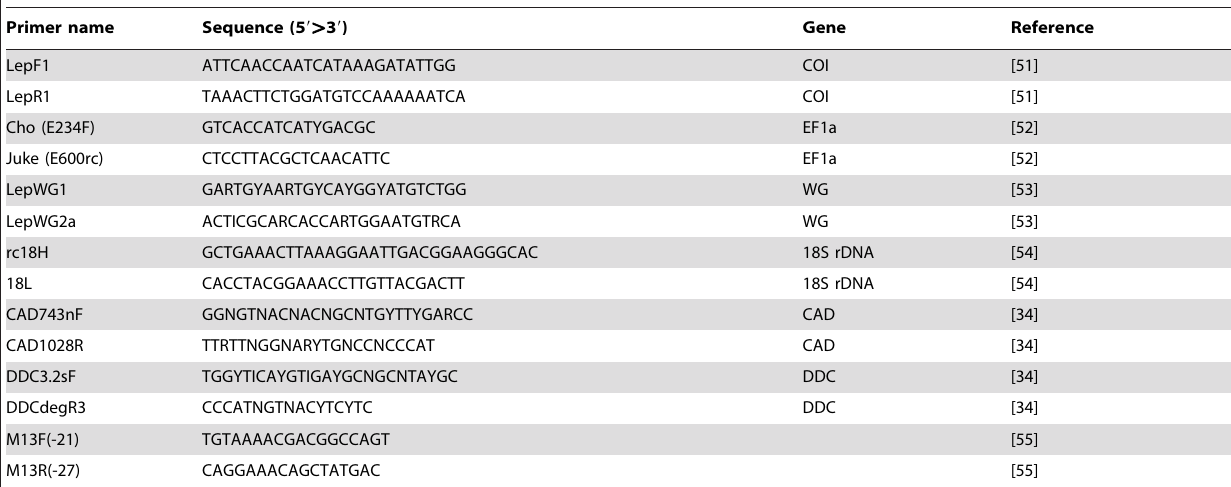
Table 2. List of primers used in this study.